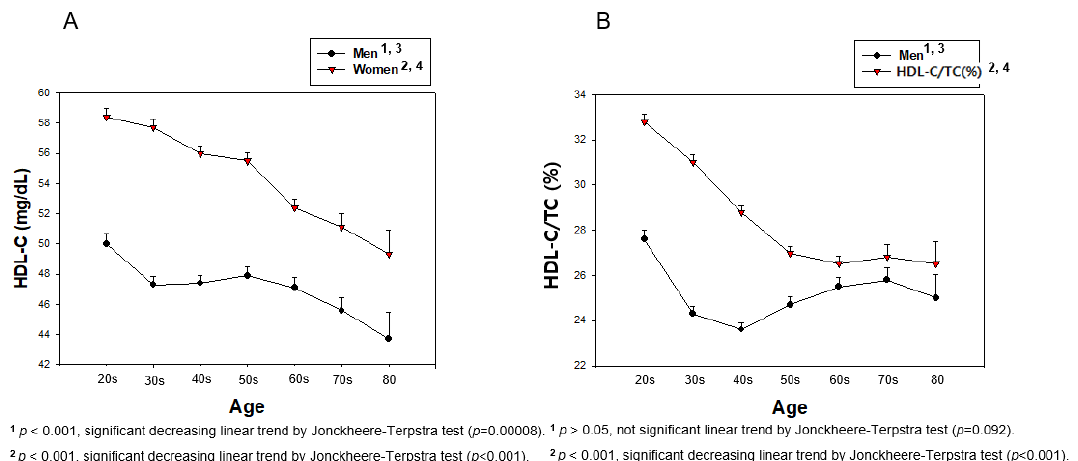
Figure 9. Change in SBP (A) and DBP (B) depends on age of men and women during entire life.